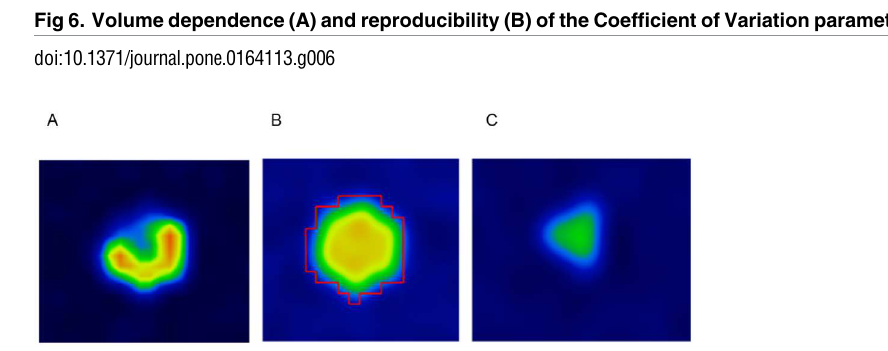
Fig 7. An axial slice of the image of Revolver insert phantom inserted into a homogeneous environment reconstructed from data of 2 min acquisition time beginning at t = 0 (A), t = 45 min (B), and t = 80 min (C). Boundaryof the appliedVOI is also displayedon panel